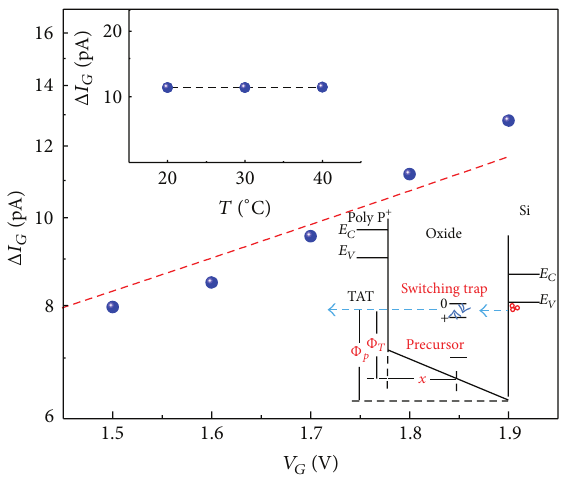
Figure 5: The field dependence of Δ𝐼 𝐺 amplitude. The red dash line presents the simulation results by trap-assisted tunneling (TAT) modeling. The inset shows temperature behaviors of Δ𝐼 𝐺 .